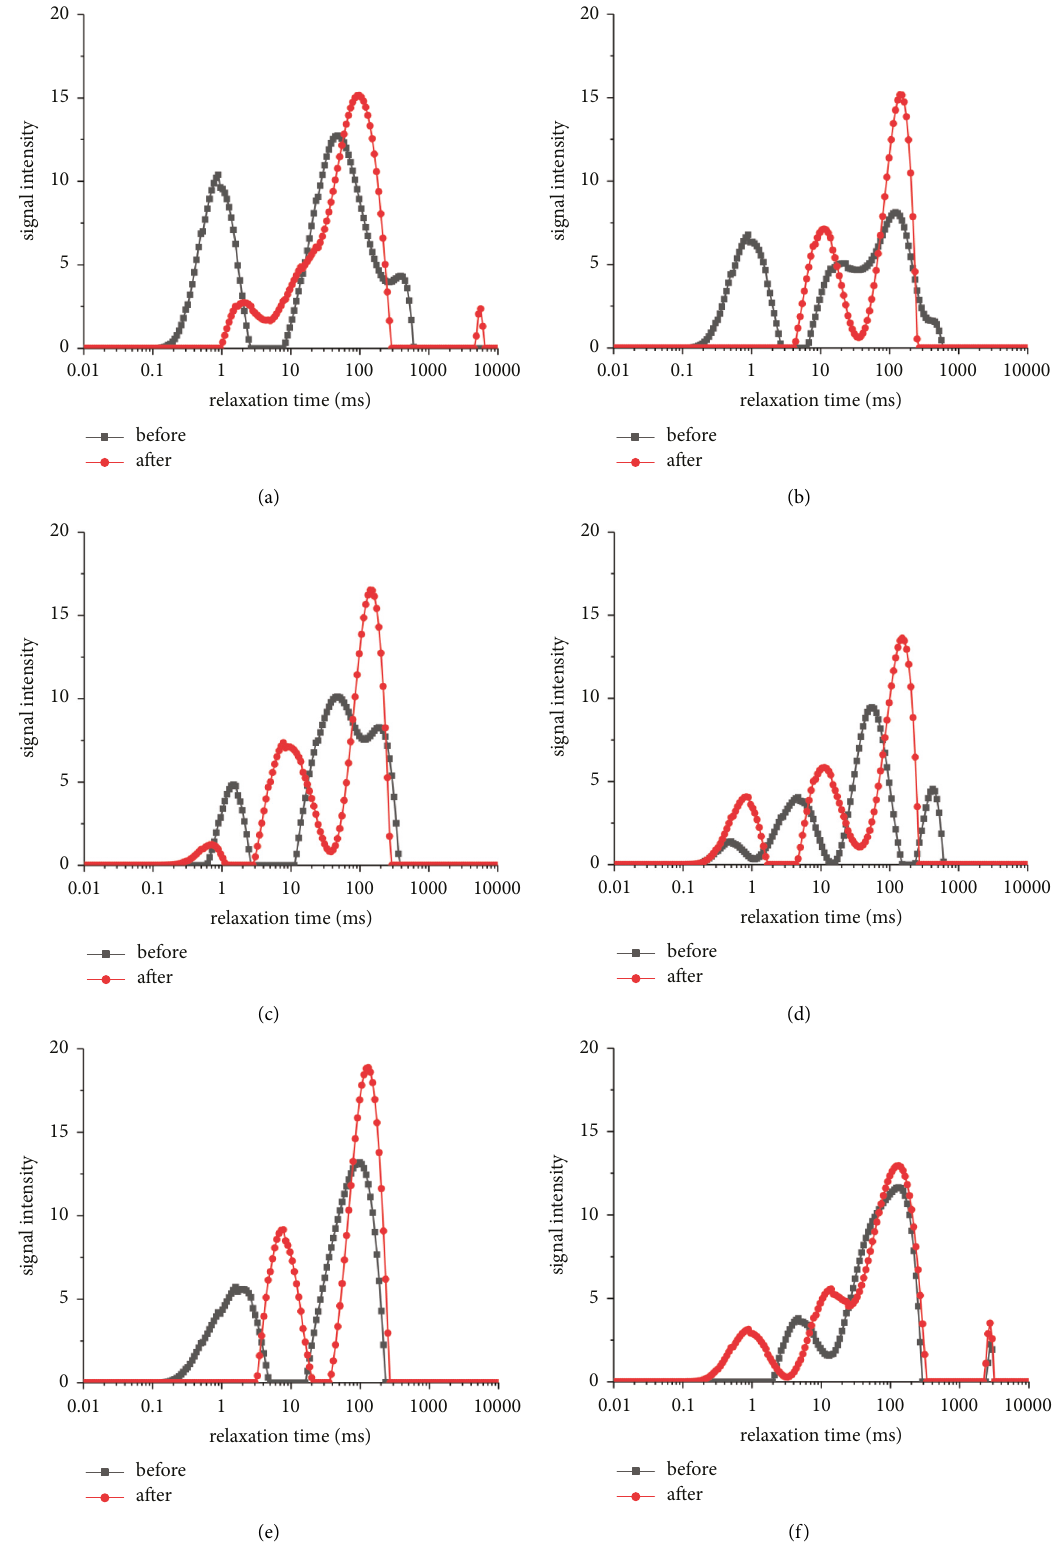
Figure 3: T2 spectrum before and after ultrasonic vibration under different amplitudes: (a) 50%, (b) 60%, (c) 70%, (d) 80%, (e) 90%, (f)